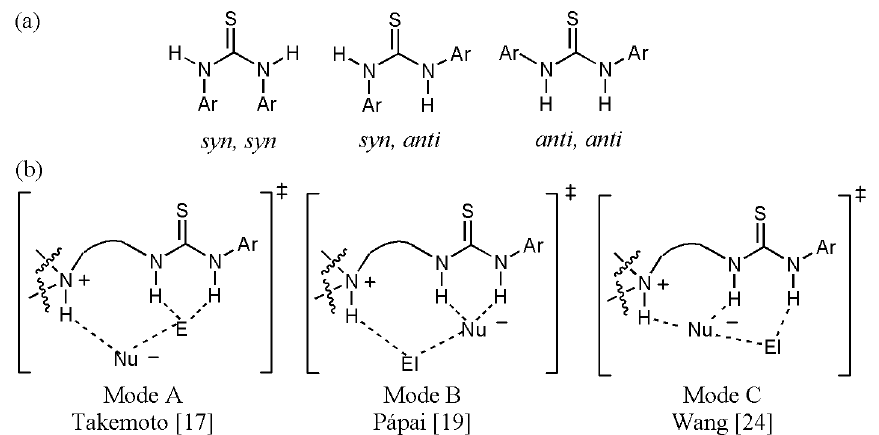
Figure 4. ( a ) Possible binding conformations of thiourea and ( b ) modes of activation proposed for thiourea-tertiary amine organocatalysis [17,19,24].